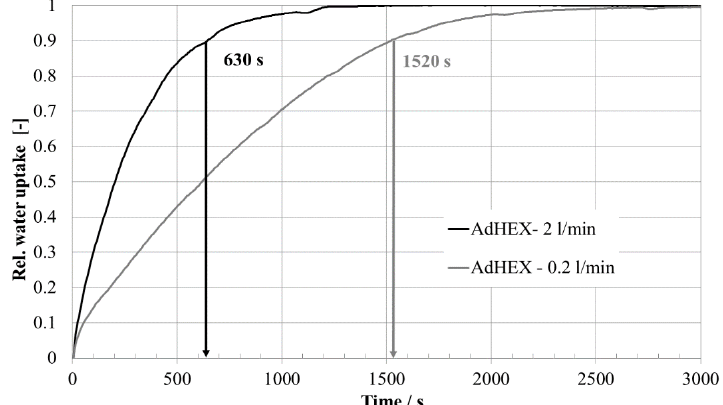
Figure 7. Comparison of water uptake behavior of the composite material in an